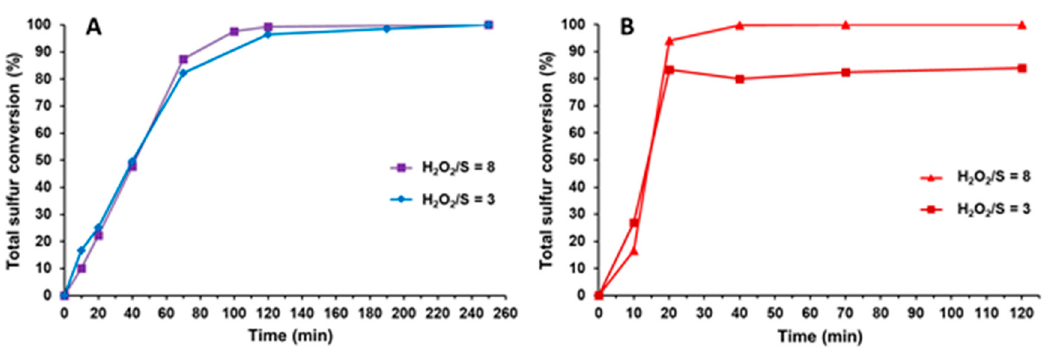
Figure 2. Total conversion data obtained for the oxidation of a multicomponent sulfur model diesel (2000 ppm S) at 70 °C using ( A ) TBA[PW 11 ] and ( B ) ODA[PW 11 ] catalysts (3 μ mol) and different amounts of H 2 O 2 as oxidant.